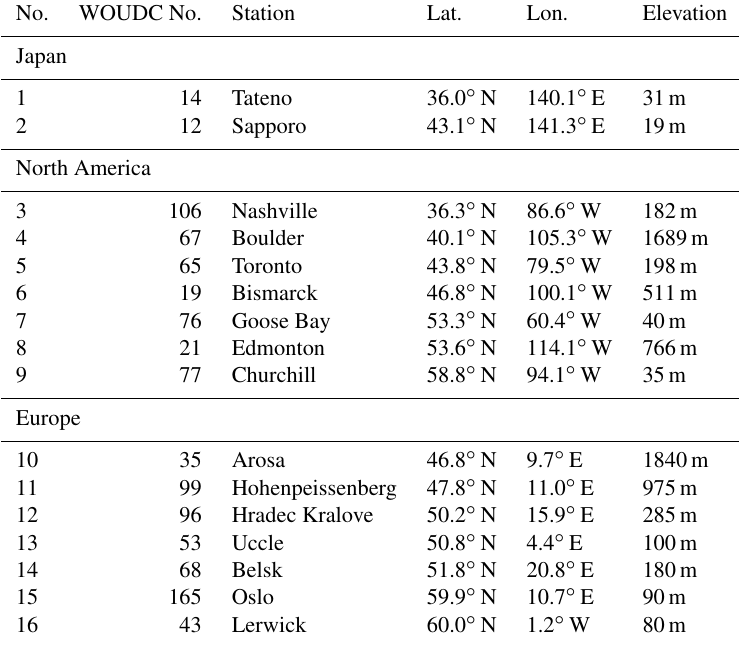
Table 1. Selected ground-based total column ozone observing stations in the NH mid-latitudes with the data record archived in WOUDC. No. WOUDC No. Lat.